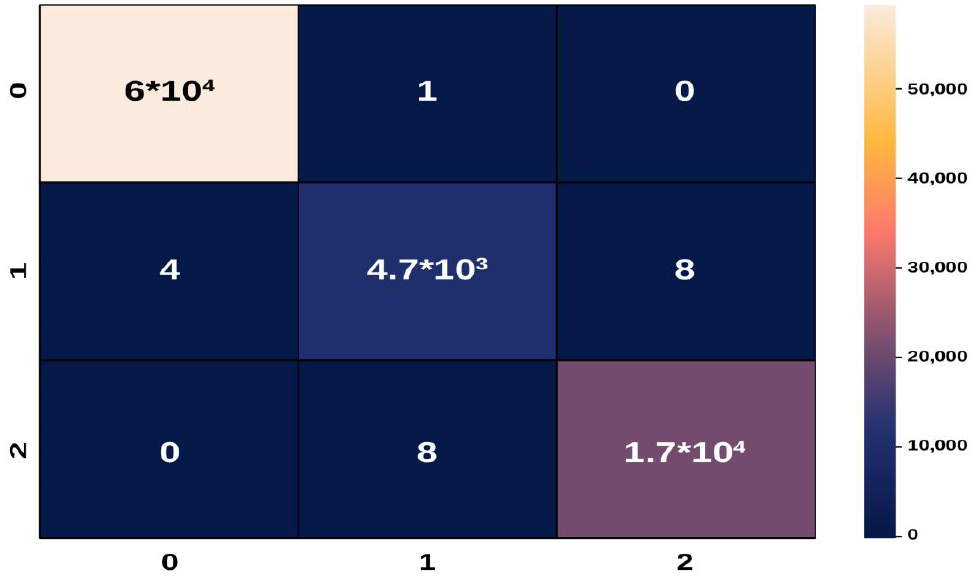
Figure 11. Confusion Matrix.